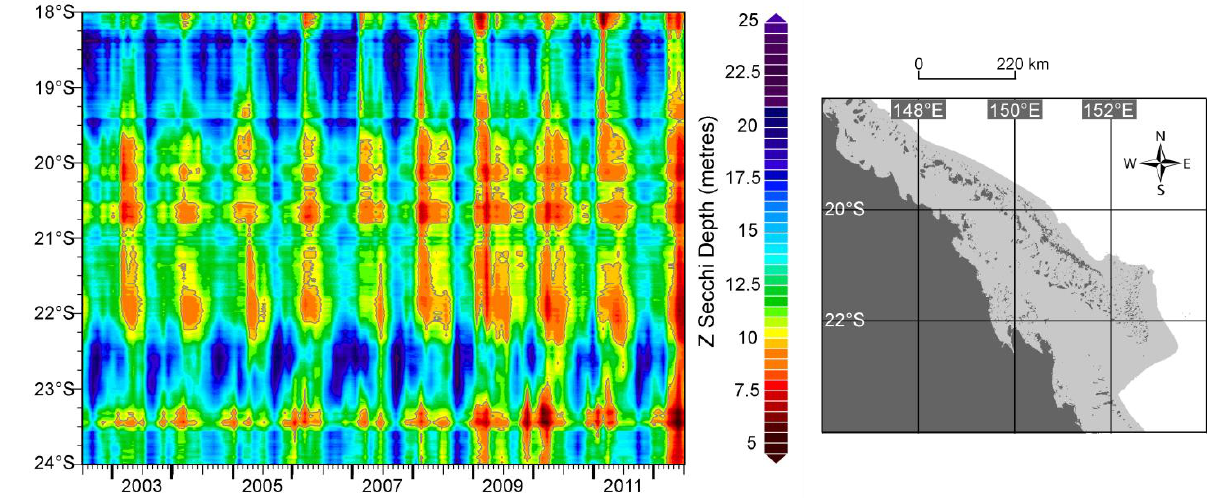
Figure 5. Hovmöller diagram illustrating the variation of water clarity on the central-southern Great Barrier Reef in space (18°S–24°S) and time (July 2002–June 2012). Areas with mean cross-shelf Secchi depth <10 m are highlighted by grey contour. The right-hand panel shows the bathymetry mask used to limit the spatial domain to 0–200 m, excluding reef features.